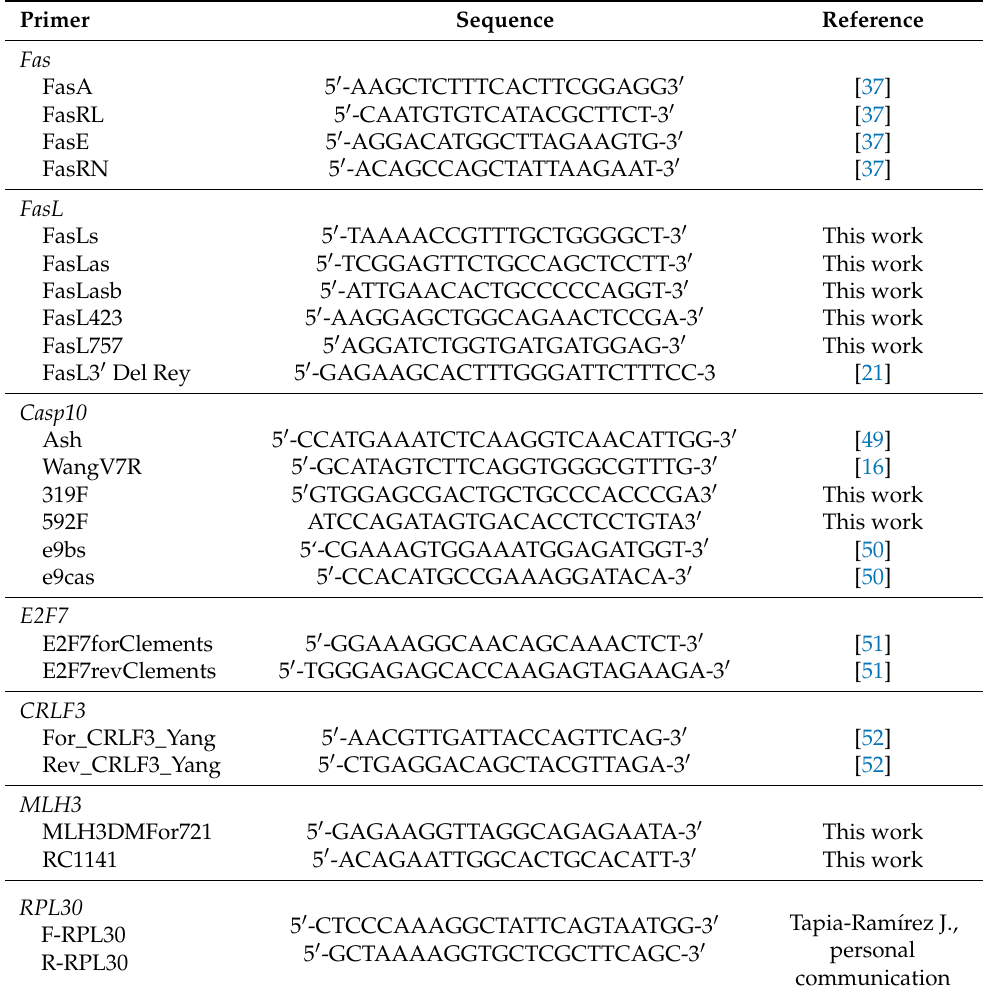
Table 5. Oligonucleotide primers used in this